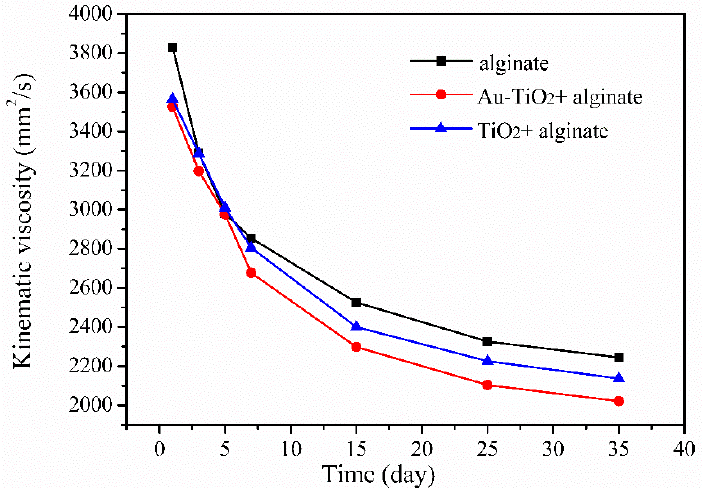
Figure 6. Degradation curve of the pure alginate and Au-TiO 2 nanocomposites added alginate solutions.